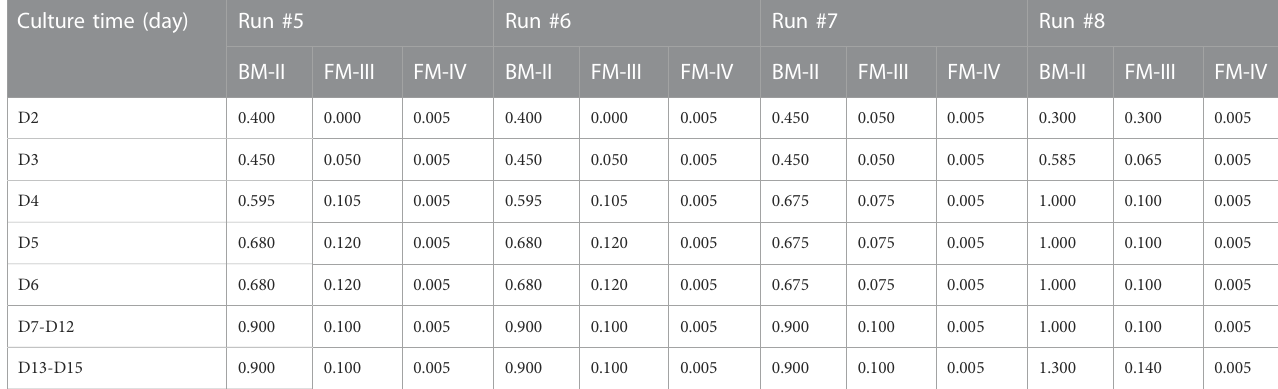
TABLE 2 The optimization of perfusion culture in runs #5-#8 by using 3-L bioreactor. Culture time